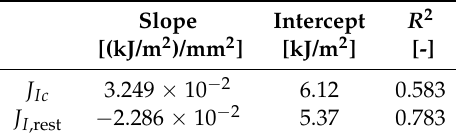
Table 1. Function parameters and correlation coefficients of the linear regressions between J Ic and J I ,test vs. crack length.